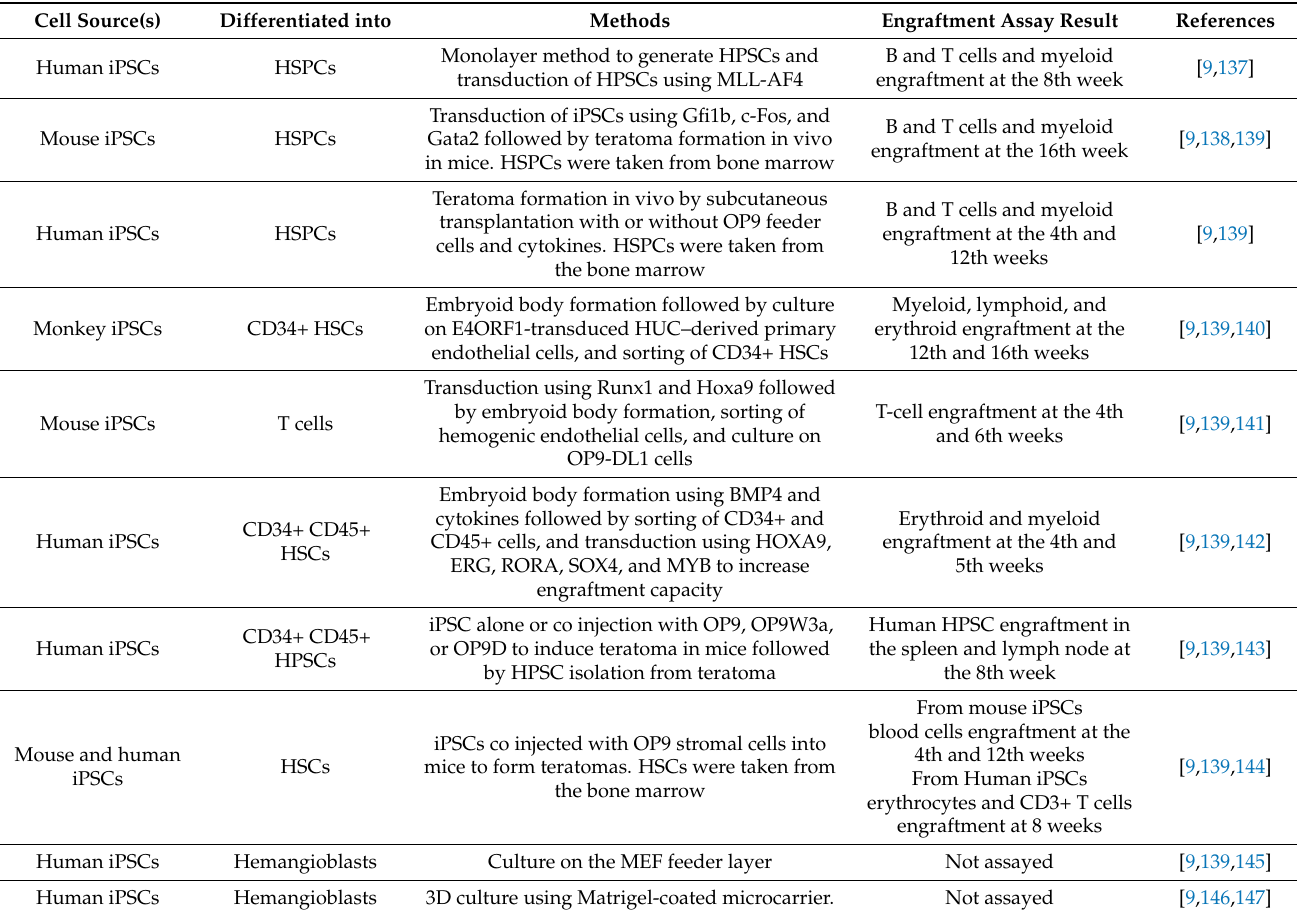
GFi1B: Growth factor independent 1B transcriptional repressor, a protein-coding gene. E4ORF1: Control protein E4 open reading frames (ORFs). HUC: Human umbilical cord. ERG: (E-twenty-six)-related gene, a critical factor protecting HSCs from differentiation. Hoxa9: Homeobox protein Hox-A9. MEF: Mouse embryonic fibroblast. MYB: A gene encoding various transcription factors that contain typical DNA binding motifs, a master regulator of hematopoietic system development and function. NSG: NOD scid γ , NOD.Cg-Prkdc